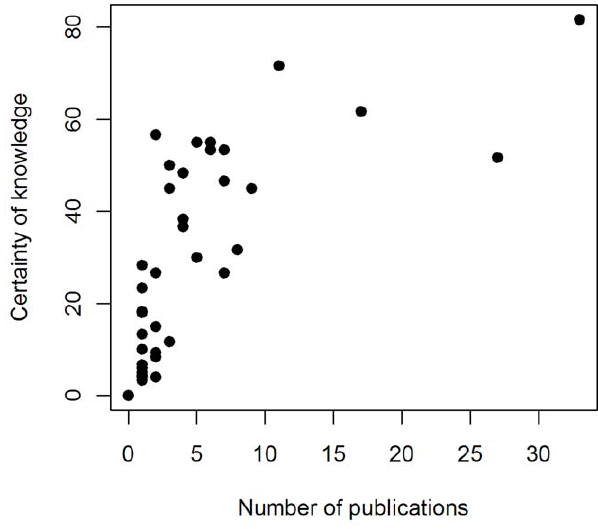
Figure 6. Certainty of knowledge score related to the number of publications addressing effectiveness for each